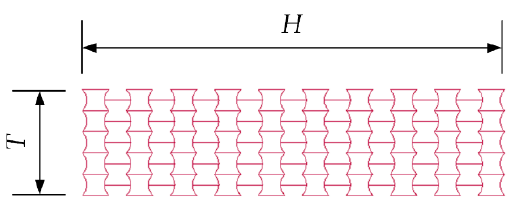
Figure 2. Dimensions of the structure. Table 1. Dimensions of each unit cell of the honeycomb core.